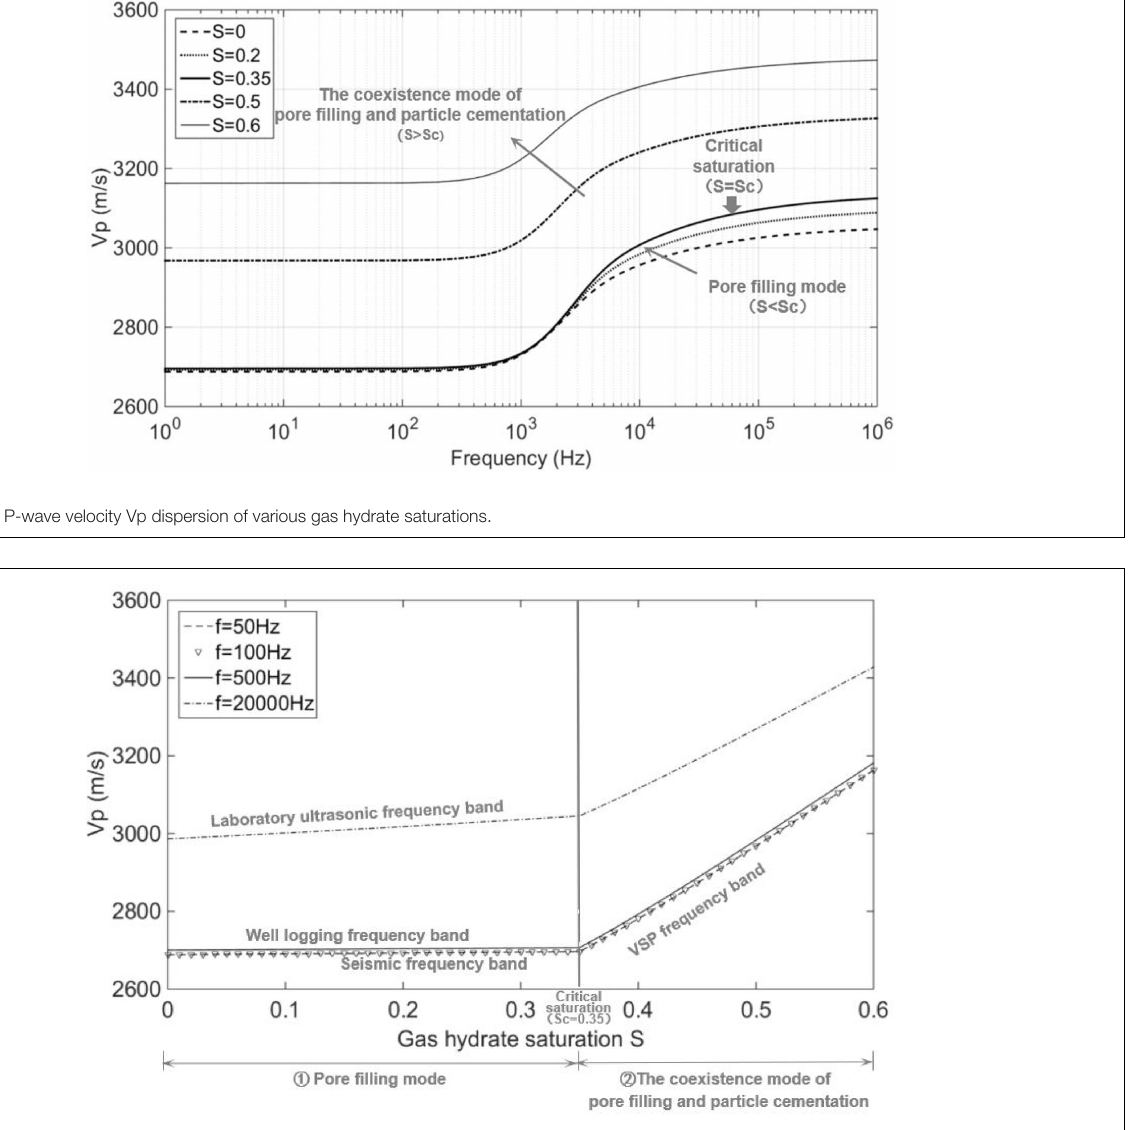
FIGURE 5 | Variations of the P-wave velocity Vp with gas hydrate saturation S for different